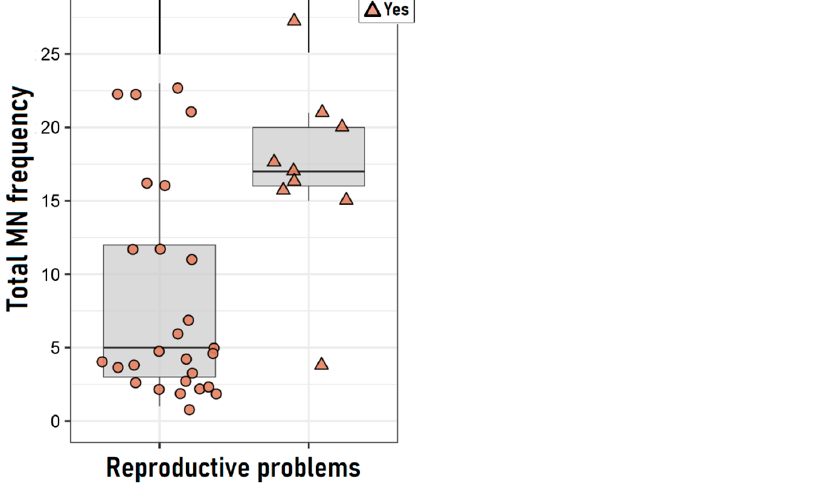
Figure 3. Cytogenetic damage level between women who have reported reproductive problems and those who have not. *** p < 0.003 U -Mann Whitney test.